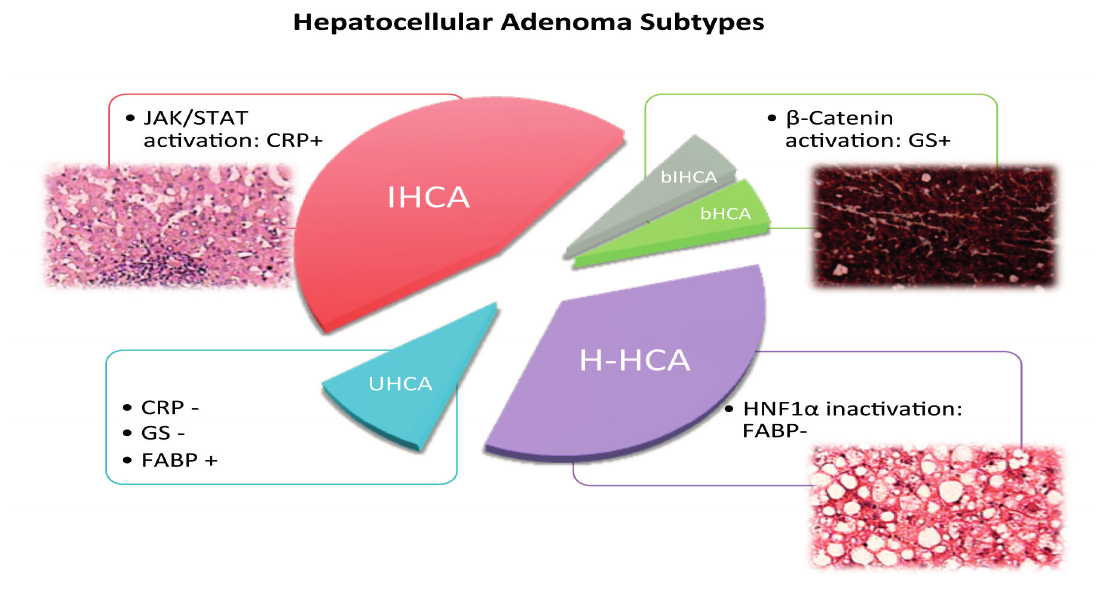
Figure 2. Hepatocellular Adenoma Subtypes. Three main subgroups are currently distinguished among hepatocellular adenomas (HCA). The inflammatory group (IHCA) accounts for 45% of HCA and is characterized by an activation of the JAK/STAT pathway, resulting in an inflammatory phenotype with sinusoidal dilation and inflammatory infiltrates (red). Diagnosis is based on immunohistochemical CRP expression. The subgroup of β -catenin activated HCA is split into two: solely β -catenin activated HCA (bHCA, green) and tumors that in addition to β -catenin activation display inflammatory phenotypes (bIHCA, gray). Together, they account for 10% of HCA. In most cases, diagnosis is rested on diffuse immunohistochemical GS expression. The second most frequent subgroup is characterized by a loss of HNF1 α and comprises 35% of HCA (H-HCA, purple). Phenotypically, these tumors display steatosis and are found to display negative FABP immunohistochemical staining. The fourth subtype to be depicted is the yet unclassified group of HCA (UHCA, blue). CRP: C-reactive protein; GS: glutamine synthetase; FABP: fatty acid binding protein